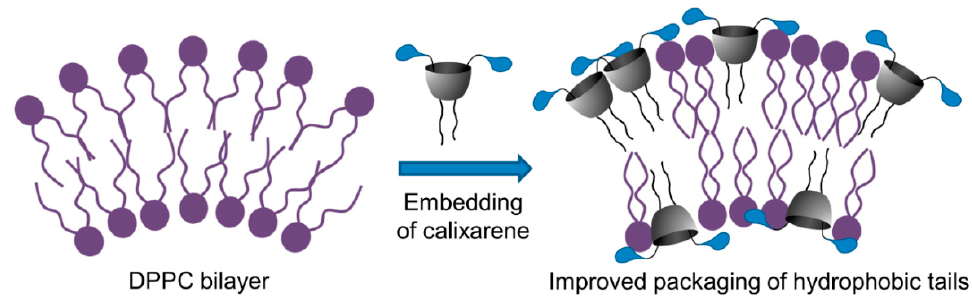
Figure 4. Schematic representation of improved packaging of hydrophobic tales in mixed DPPC– calixarene 5 vesicles.